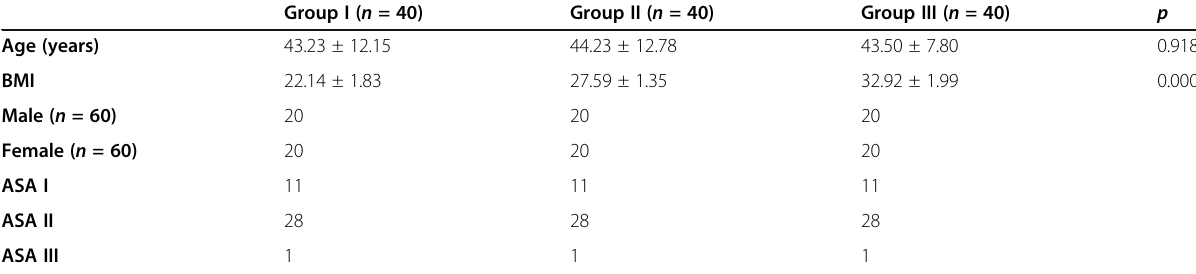
Table 1 Demographic data of cases (mean ± SD)